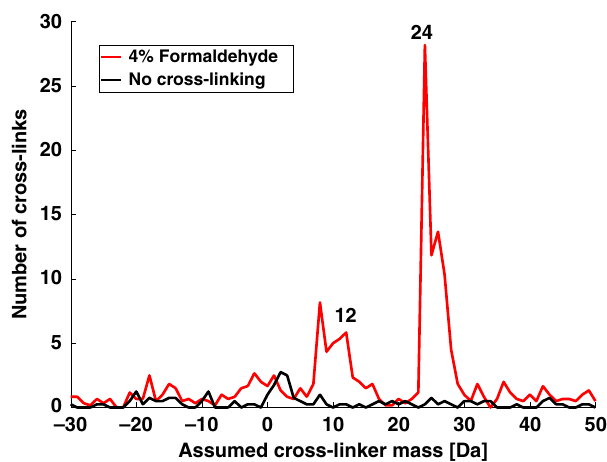
Fig. 2 FA cross-linking adds 24 Da to the peptide pairs. Standard search for cross-links in mass spectrometry data from the setup that is described in Fig. 1. The Y -axis counts the number of identi fi ed cross-links. The search was repeated multiple times, each time assuming a different mass ( X -axis) being added by the cross-linking reaction to the total mass of the two linked peptides. Overlaid are mass scans from an experiment with high (4%) FA concentration (red) and a control without cross-linking (black). Previously, FA cross-links were thought to be primarily methylene bridges that add 12 Da, but in fact these contribute to very few identi fi cations. Source data are provided as a Source Data fi